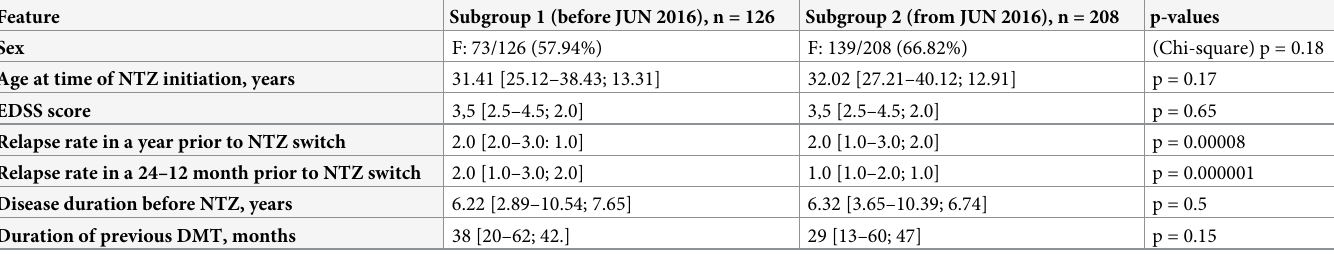
Table 2. Subgroup comparison